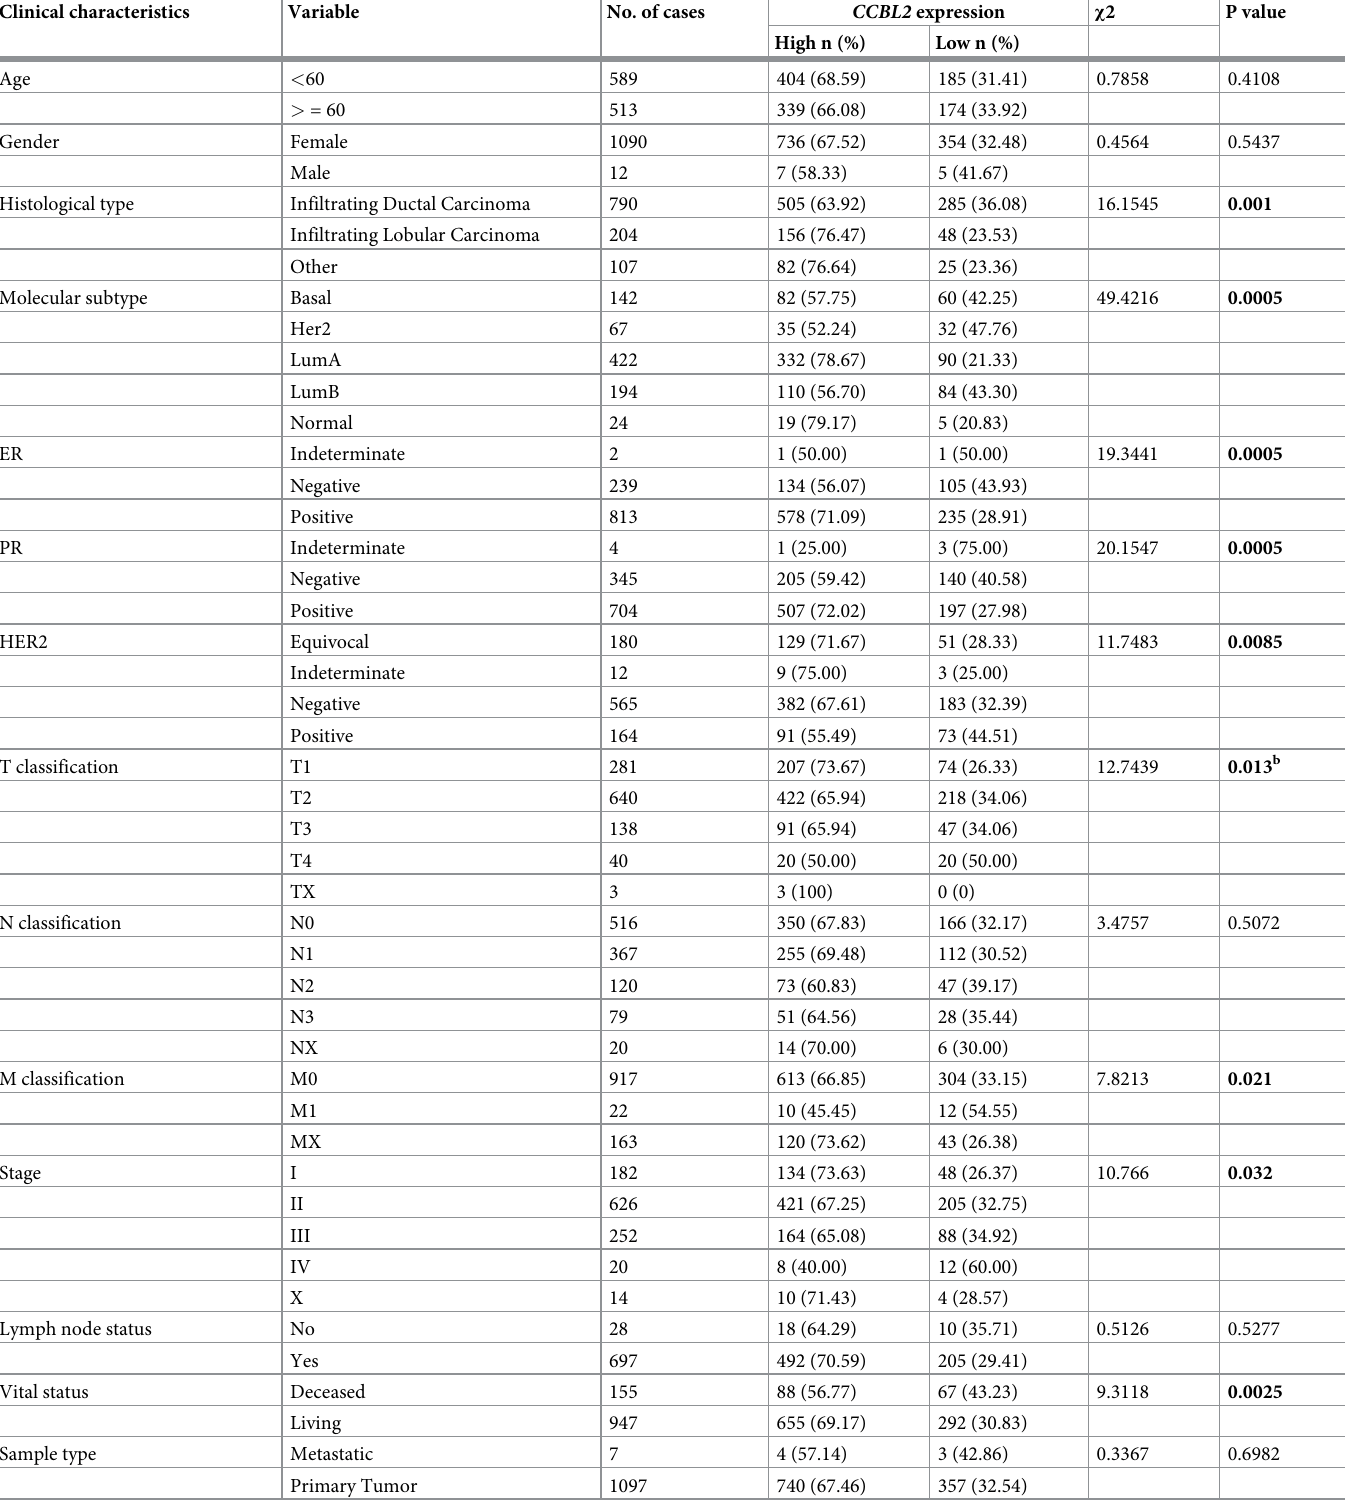
Table 2. Correlations of CCBL2 expression in BC tissues with clinicopathologic